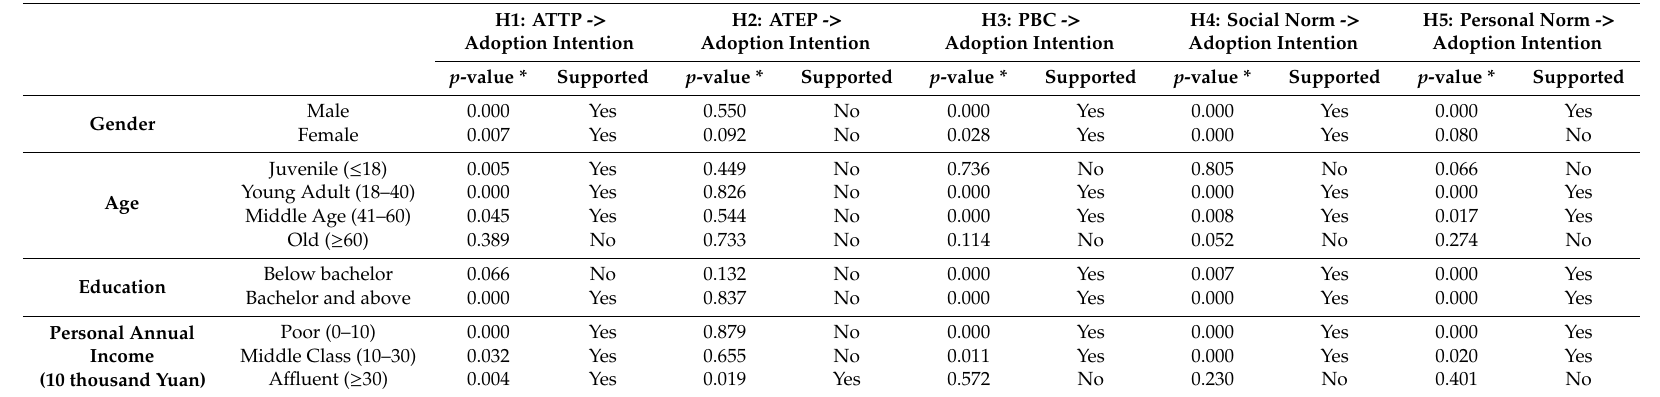
Table 8. Hypothesis test results by category of demographic